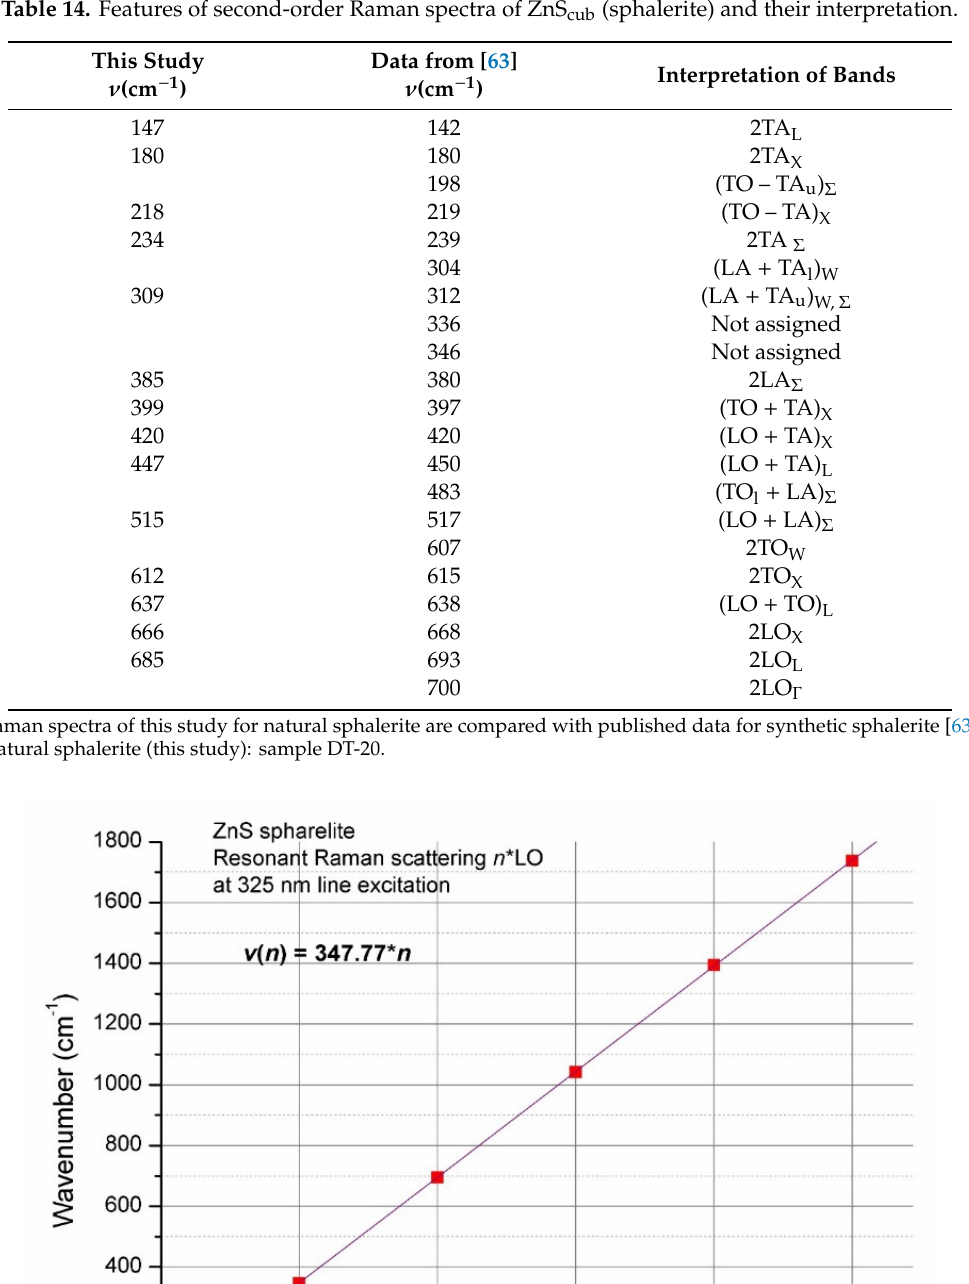
Table 14. Features of second-order Raman spectra of ZnS cub (sphalerite) and their interpretation.